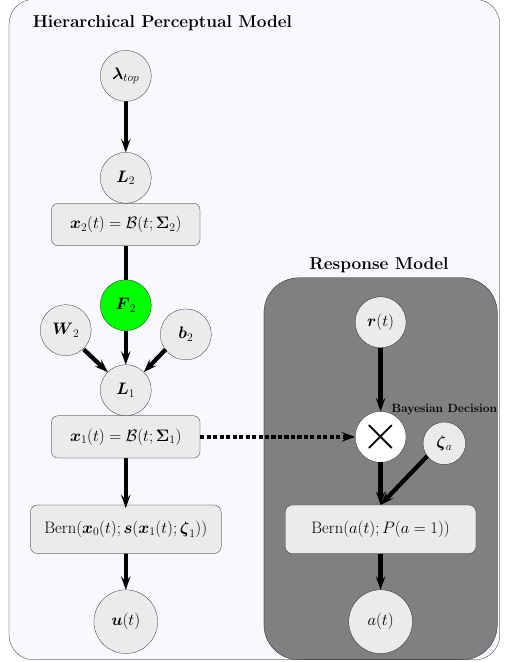
Figure 4. A Bayesian agent consists of the proposed hierarchical perceptual model and a binary response model based on Bayesian decision theory. The reward r ( t ) = [ r 0 ( t ) , r 1 ( t )] T is drawn uniformly from a set on each